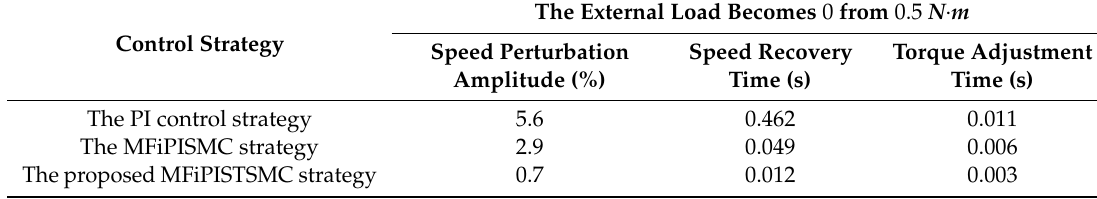
Table 5. The comparative results of the load decreased